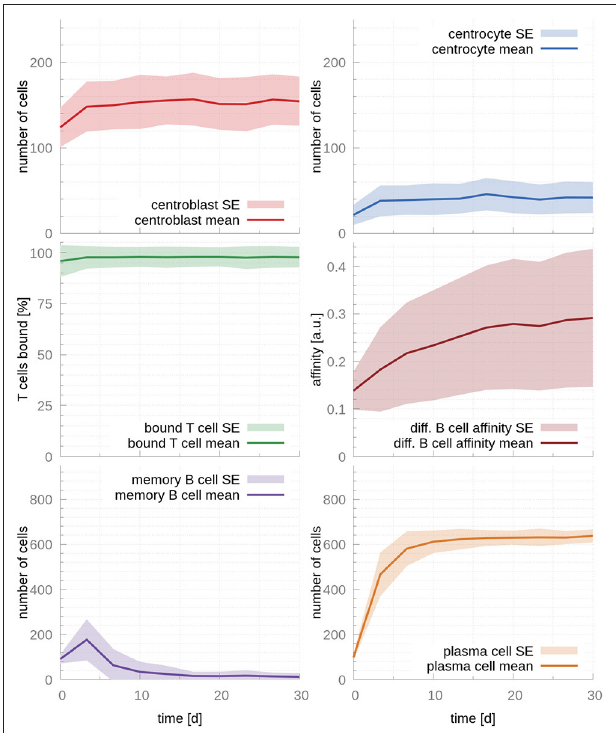
FIGURE 3 | GC cellular populations over time for the set of fitted parameters. Parameters were fitted to experimental observations of the GC output over time (17). Faster affinity maturation leads to a transient output of MBC at early time points that dwindles and vanishes by day 10. In parallel, PCs reach a strong and steady output by the time of the temporal switch (day 10). During the whole life of the GC, the majority of T cells are bound, enabling competition between CCs and, hence, production of PCs. In the figures above, germinal center cell counts are the average number of concurrent cells, while cells leaving the germinal center are accumulated per periods of 18 h. The shaded area depicts standard error (SE).